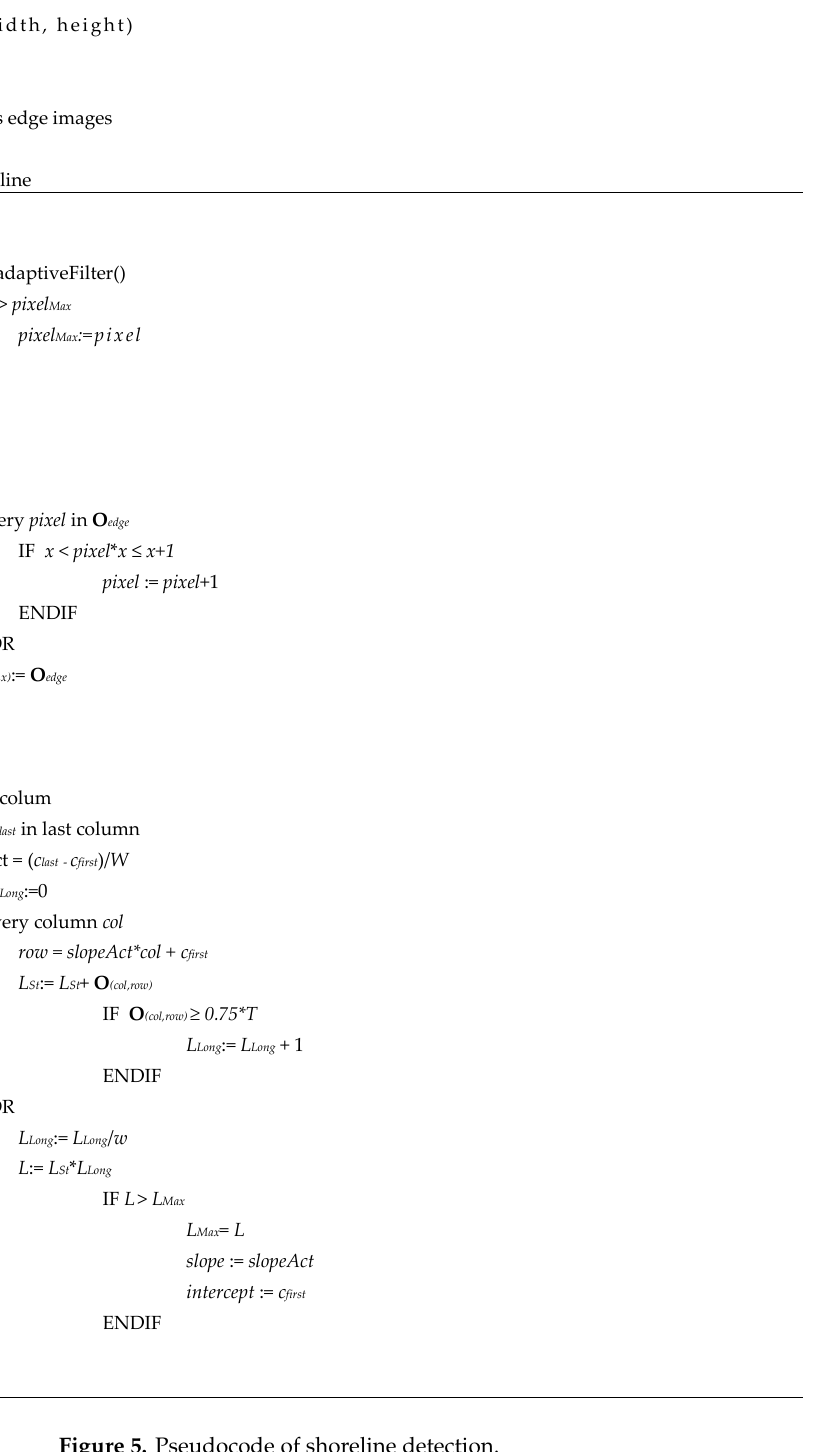
Figure 5. Pseudocode of shoreline detection.